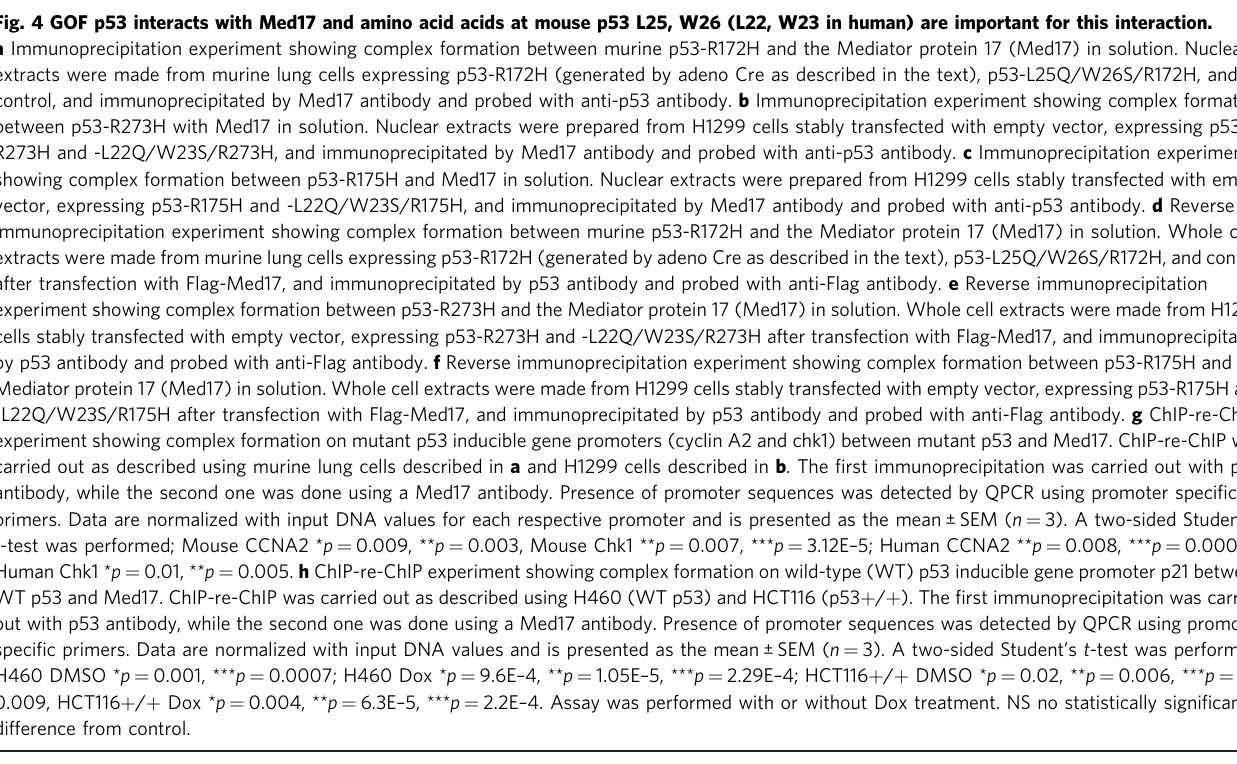
Fig. 4 GOF p53 interacts with Med17 and amino acid acids at mouse p53 L25, W26 (L22, W23 in human) are important for this interaction. a Immunoprecipitation experiment showing complex formation between murine p53-R172H and the Mediator protein 17 (Med17) in solution. Nuclear extracts were made from murine lung cells expressing p53-R172H (generated by adeno Cre as described in the text), p53-L25Q/W26S/R172H, and control, and immunoprecipitated by Med17 antibody and probed with anti-p53 antibody. b Immunoprecipitation experiment showing complex formation between p53-R273H with Med17 in solution. Nuclear extracts were prepared from H1299 cells stably transfected with empty vector, expressing p53- R273H and -L22Q/W23S/R273H, and immunoprecipitated by Med17 antibody and probed with anti-p53 antibody. c Immunoprecipitation